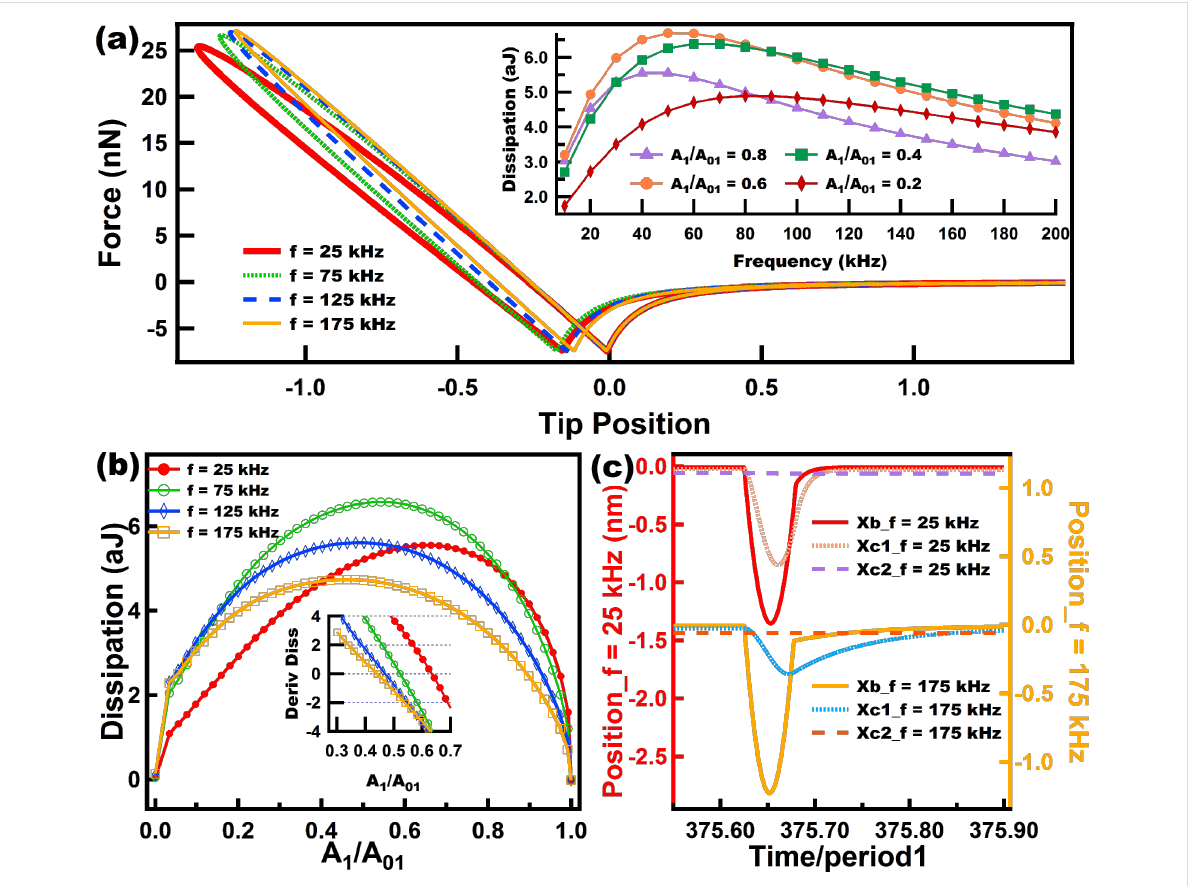
Figure 8: Results of energy dissipation when a tip interacts with a Nafion model under a numerically simulated trajectory. (a) Shows force distance curves for tips driven at different eigenfrequencies (color coded). The inset in (a) shows the behavior of dissipation as the frequency increases, and each color coded line relates to a specific amplitude setpoint ( A 1 / A 01 ). (b) shows dissipation vs amplitude setpoint ( A 1 / A 01 ) curves, where each color coded line corresponds to a specific eigenfrequency. The inset in (b) shows the slope of the curves in (b) near the range where the slopes cross the x -axis in order to easily locate the maxima of the curves in (b). (c) shows the response of the surface and dashpots of the Nafion model for two cases at different cantilever eigenfrequencies. The parameters for the cantilever dynamics were the same as in Figure 6 and Figure 7. The sample parame- ters were: k e = 20 N/m, k 1 = 10 N/m, k 2 = 5 N/m, c 1 = 0.5 × 10 − 5 N·s/m, and c 2 = 100.0 × 10 − 5 N·s/m. Time normalization has been carried out in (c) with respect to the fundamental period for ease of